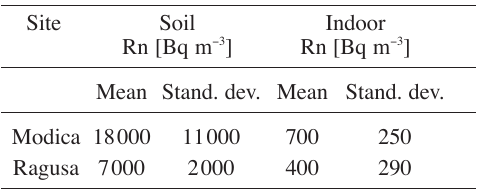
Table I. Indoor and soil radon concentration means all over the investigation